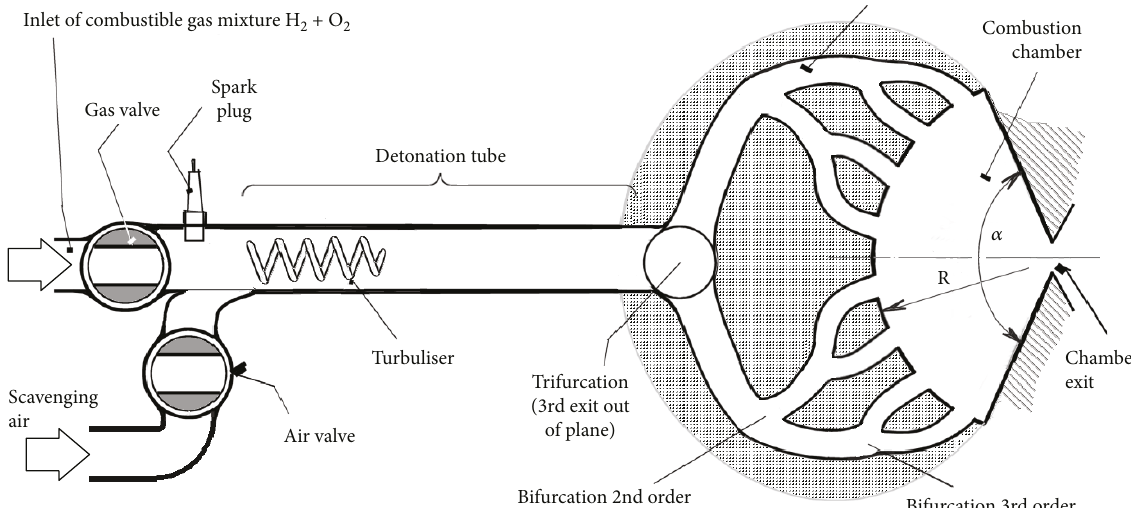
Figure 1: Schematic representation of the investigated single-shot laboratory test model. The cumulative e ff ect is reached in the focal point near the chamber exit — where the temperature levels approach those needed for e ffi cient thermal plasma